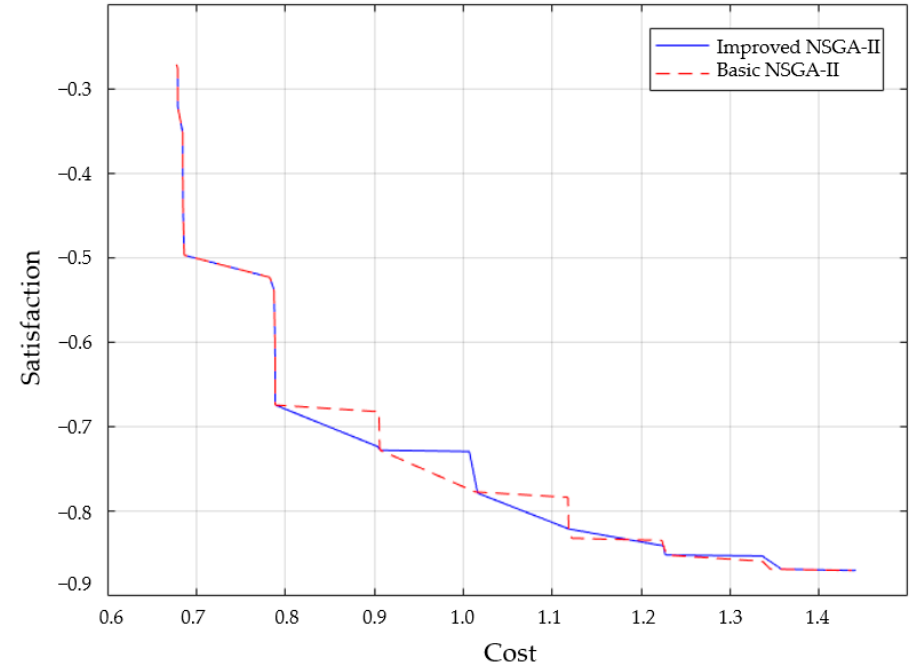
Figure 16. Algorithm convergence curve